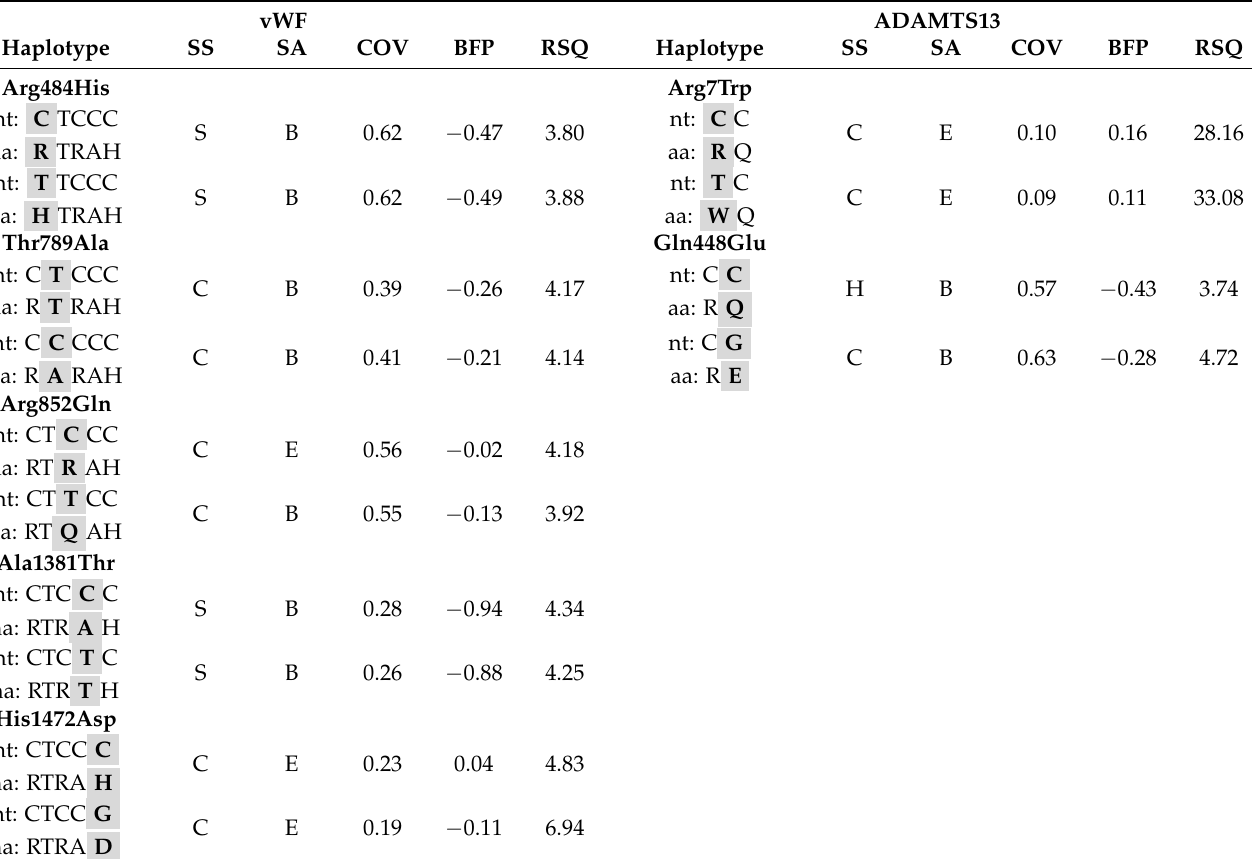
Table 7. Conformational analysis of missense variants of vWF and ADAMTS13. Quantitative descriptors of predicted steric structures are shown in relation to the most frequently occurring haplotype (‘R484 T789 R852 A1381 H1472’ for vWF (left panel) and ‘R7 Q448’ for ADAMTS13